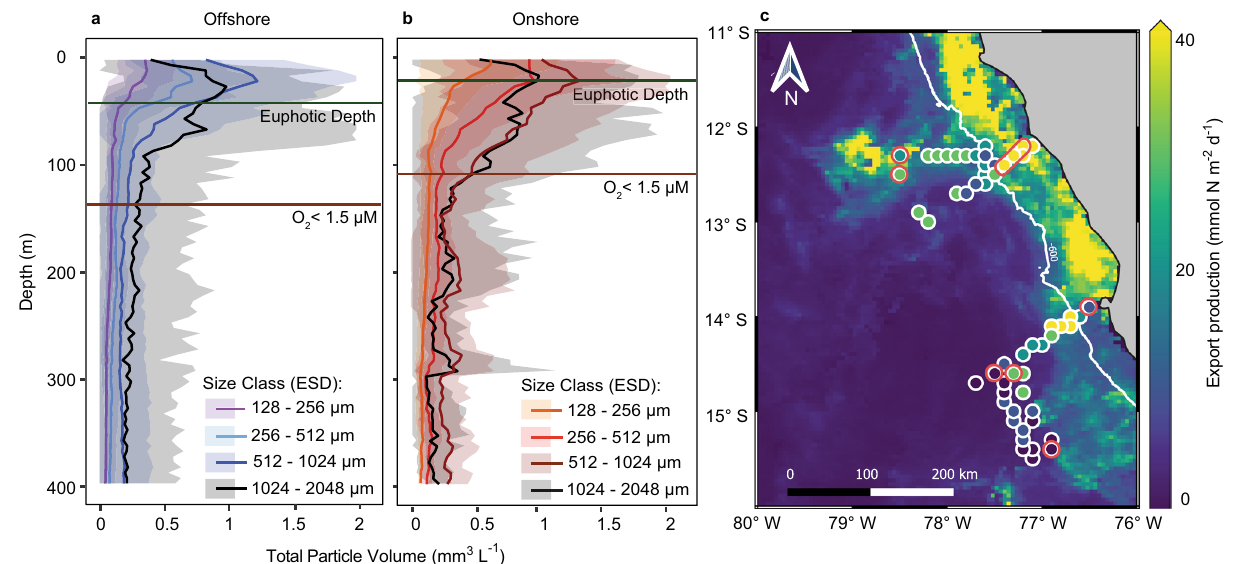
Fig. 2 Particle volume and export production in the Peruvian upwelling system during April 2017. Average particle volume pro fi les in ( a ) offshore and ( b ) onshore stations determined by the Underwater Vision Pro fi ler camera system (UVP). Particles were sorted into four size classes with equivalent spherical diameters (ESD) of 128 – 256, 256 – 512, 512 – 1024, and 1024 – 2048 µ m. The shaded envelopes correspond to standard deviation in abundances from 56 offshore and 37 onshore stations (cropped at 2 mm 3 L − 1 for visualization purposes). The base of the euphotic zone (where photosynthetically active radiation (PAR) dropped to <1%, based on Aqua-MODIS satellite data) and the oxic – anoxic interface (where O 2 dropped to <1.5 µ M) are indicated. c Export production estimated from satellite products (pseudocolor map, see the “ Methods ” section) and from particle abundances at the base of the euphotic zone (circles). The white line is the 600 m isobath on which basis the onshore and offshore stations were separated. Stations where anammox incubations were performed are circled in red, the elongated red circle encompasses four stations.